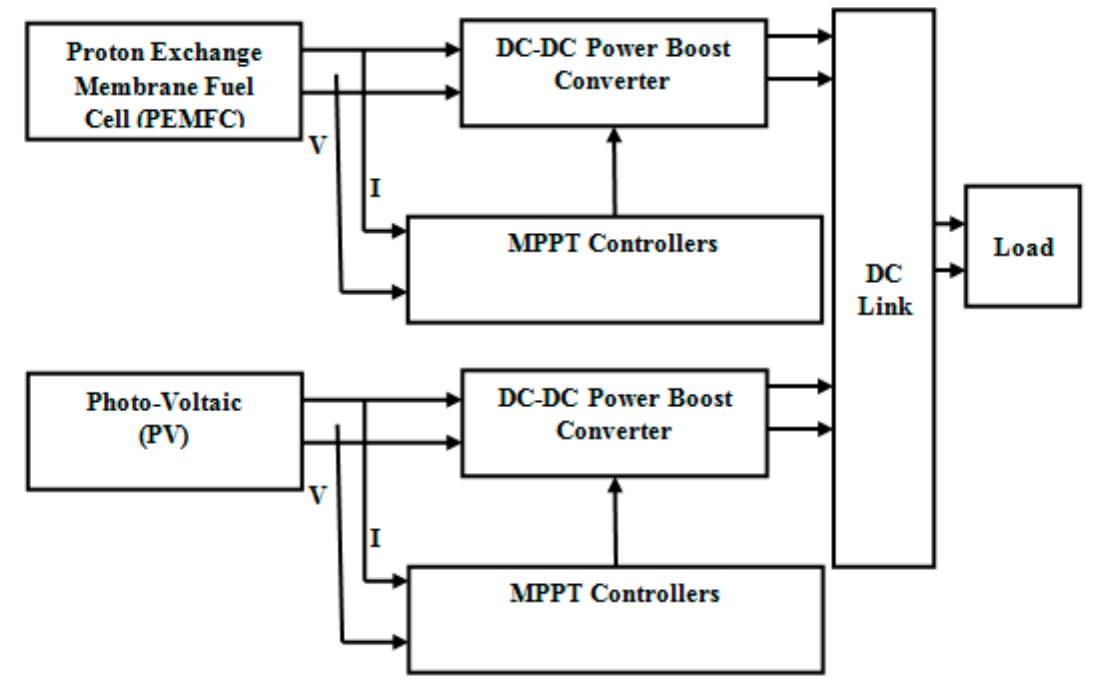
Figure 3. Proposed combination of FC–PV systems with different MPPT controllers.